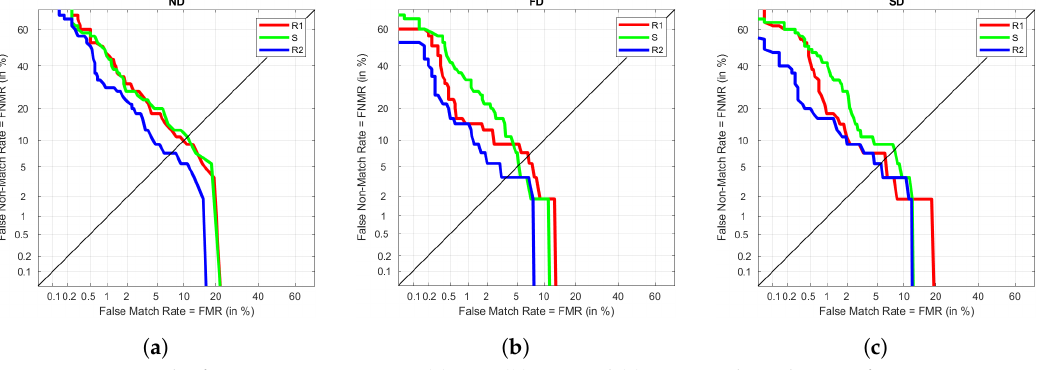
Figure 10. Results for every test set using ( a ) ND, ( b ) FD, and ( c ) SD signals with 50% of Ex as training.